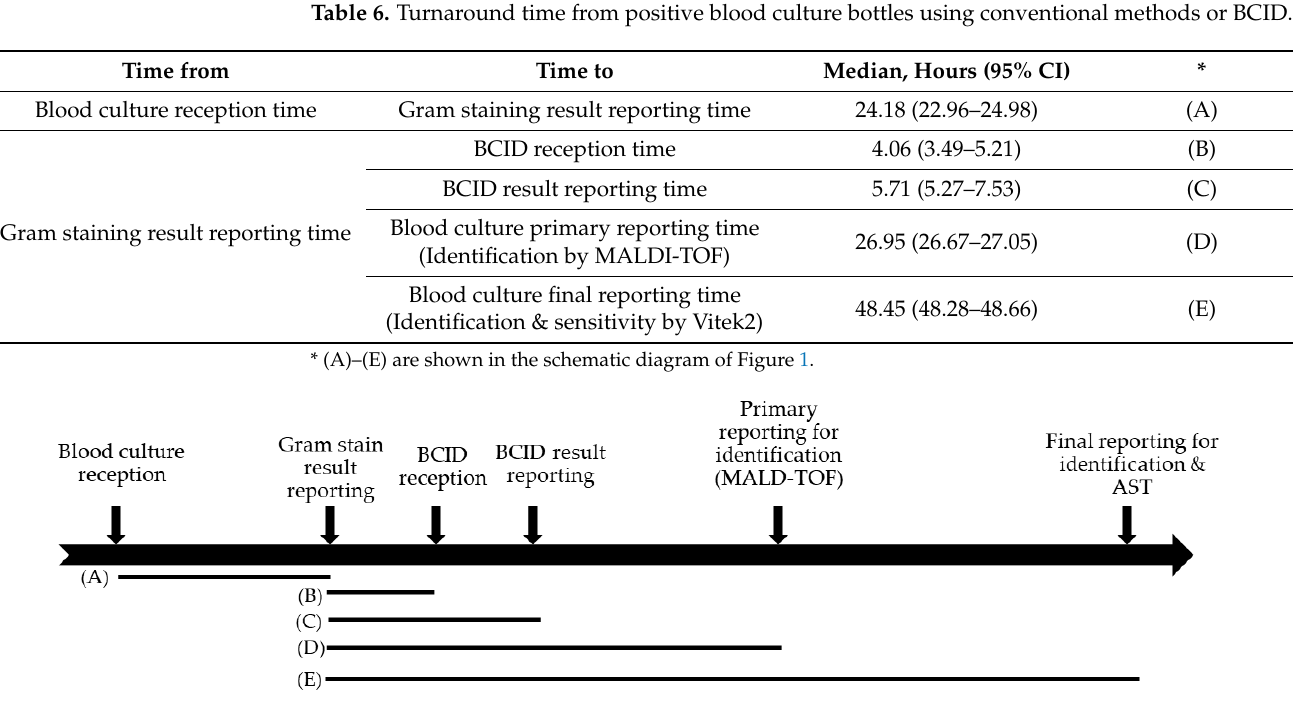
Figure 1. Schematic diagram of the blood culture reporting process of conventional and BCID blood cultures in our institution.